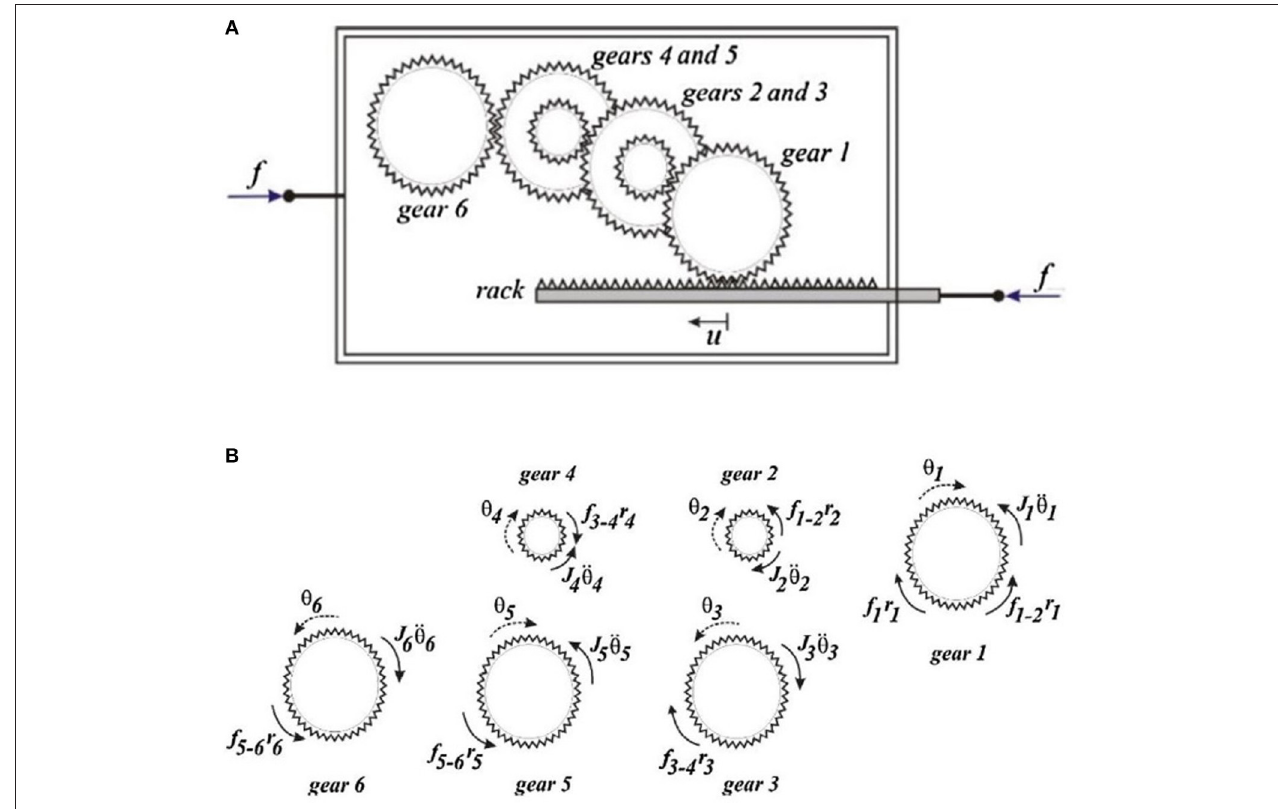
FIGURE 1 | (A) schematic representation of a GMD, (B) free body diagrams of individual gears in the GMD system (Hessabi,